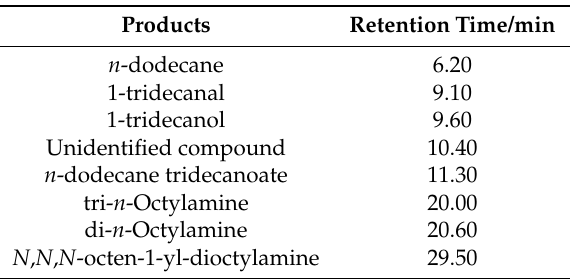
Table 1. Retention time of the products identified by GC-MS analyses in the extraction solvent after its